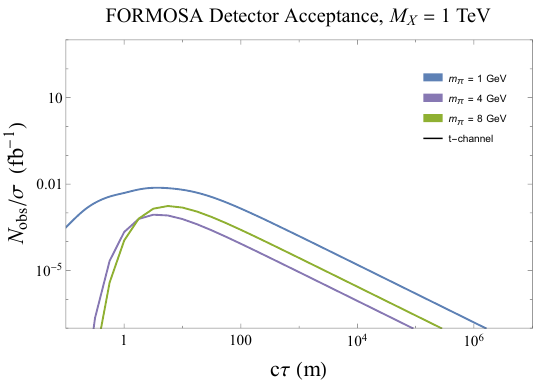
Figure 7 . Expected observed dark pions per cross section for FORMOSA as a function of dark pion lifetime. Coloured lines distinguish between different pion mass benchmarks. Solid lines represent the t -channel exchange of X d